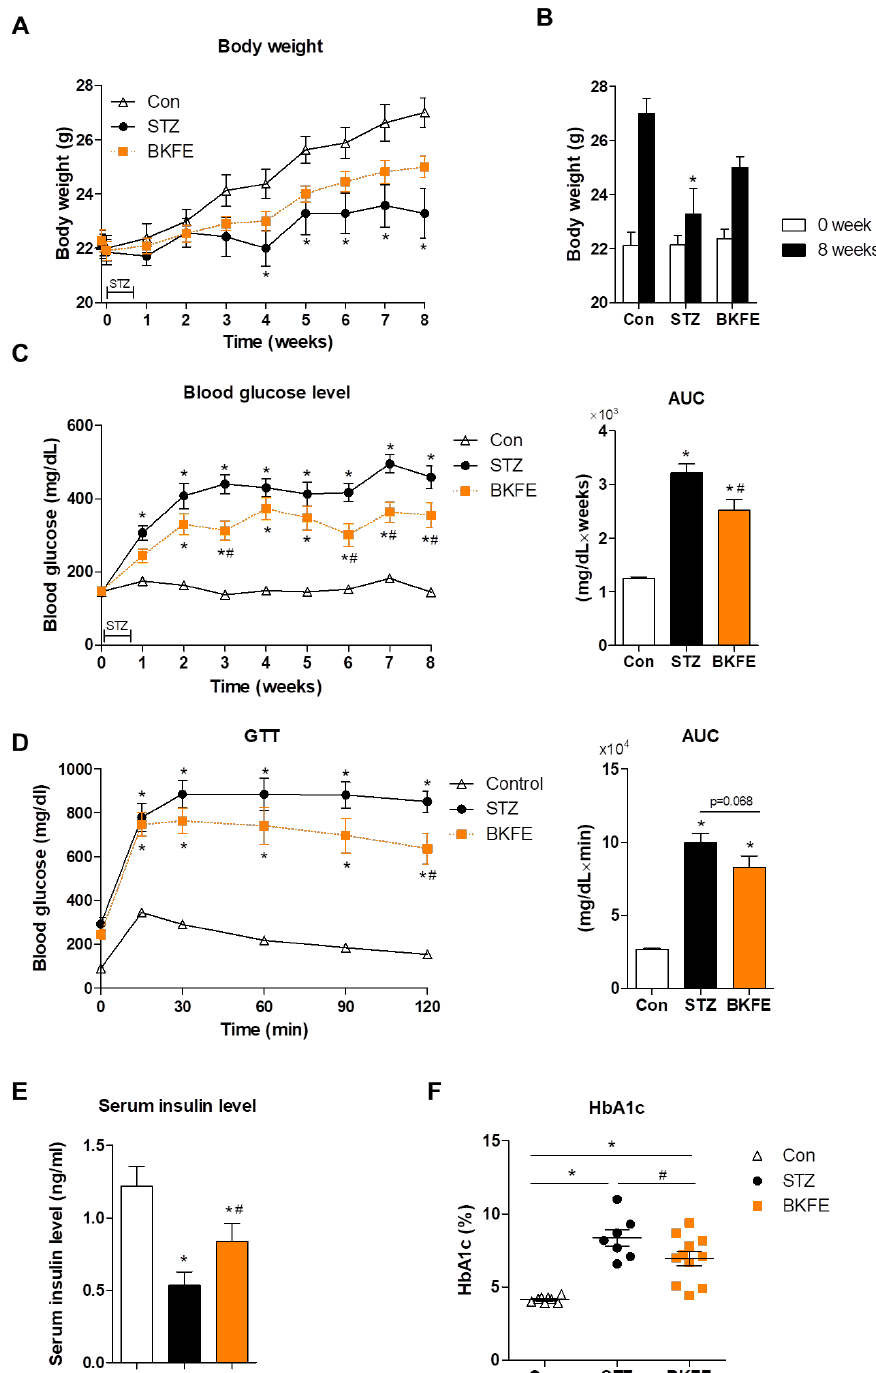
Figure 1. BKFE ameliorates STZ-induced diabetes. Diabetes was induced by multiple (for five consecutive days) low-dose (50 mg / kg) intraperitoneal (i.p.) injections of streptozotocin (STZ) in C57BL / 6 mice. Mice were orally administered either vehicle or ethanolic extract of Broussonetia kazinoki Siebold fruit (BKFE) (50 mg / kg) for eight weeks from one day before STZ injection and then sacrificed. Non-diabetic mice were administered with vehicle as a control. ( A ) Changes in body weight, ( B ) body weight before and after treatment for eight weeks, and ( C ) blood glucose levels for eight weeks were measured, and then the area under the curve (AUC) was calculated in mg · dL − 1 · week based on the blood glucose levels. ( D ) Glucose tolerance test (GTT) was performed and AUC was calculated in mg · dL − 1 · min based on the GTT curves. ( E ) Insulin and ( F ) HbA1c were measured after eight weeks of treatment. Data are presented as mean ± SEM ( n = 7–11). * p < 0.05 vs. Con; # p < 0.05 vs. STZ; Con, Vehicle-treated nondiabetes; STZ, Vehicle + STZ; BKFE, BKFE +